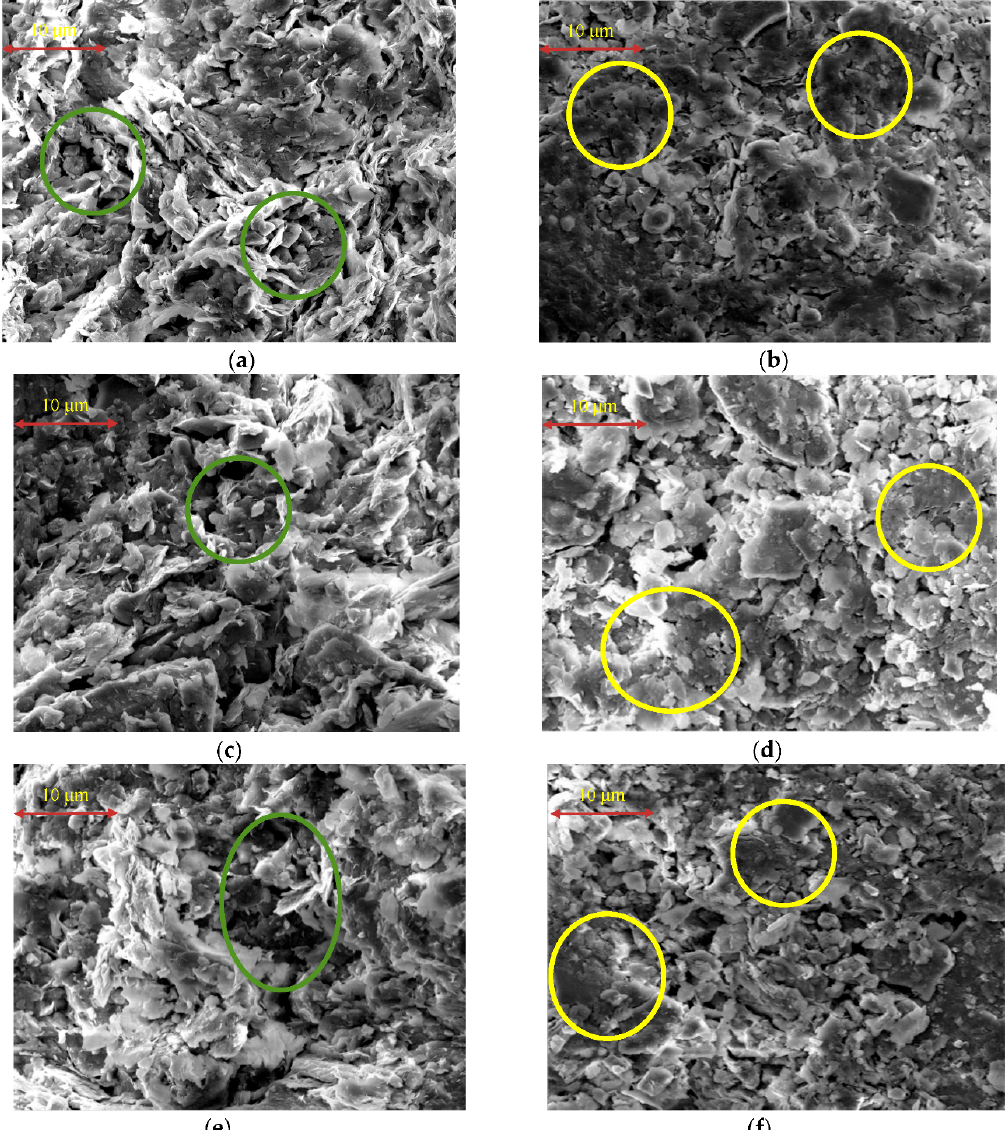
Figure 9. SEM images: ( a ) frozen–thawed soil at − 10 ◦ C before cyclic loading; ( b ) frozen–thawed soil at − 10 ◦ C after cyclic loading; ( c ) frozen–thawed soil at − 20 ◦ C before cyclic loading; ( d ) frozen–thawed soil at − 20 ◦ C after cyclic loading; ( e ) frozen–thawed soil at − 30 ◦ C before cyclic loading; ( f ) frozen–thawed soil at − 30 ◦ C after cyclic loading.